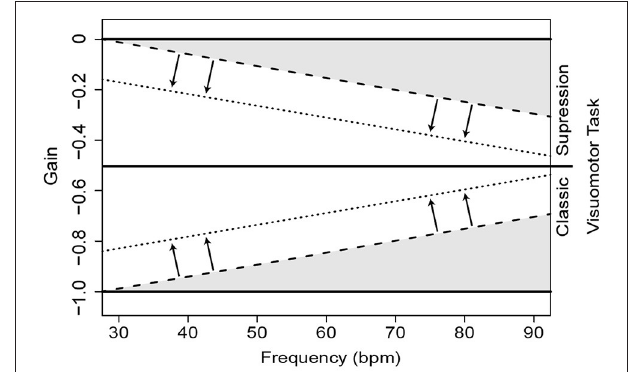
FIGURE 1 | Prediction schema of VOR gain relationship changes as a function of experience level and movement speed. Solid lines represent an optimal performance across tasks as movement speeds increase for the VOR suppression (top) and classic visuomotor task (see bottom). Decrements in performance due to experience could occur through rotation of the regression line (e.g., dashed lines and shaded portions), with steeper slopes indicating poorer performance, or through translation of the regression line (e.g., dotted lines, see arrows), representing a shift in baseline